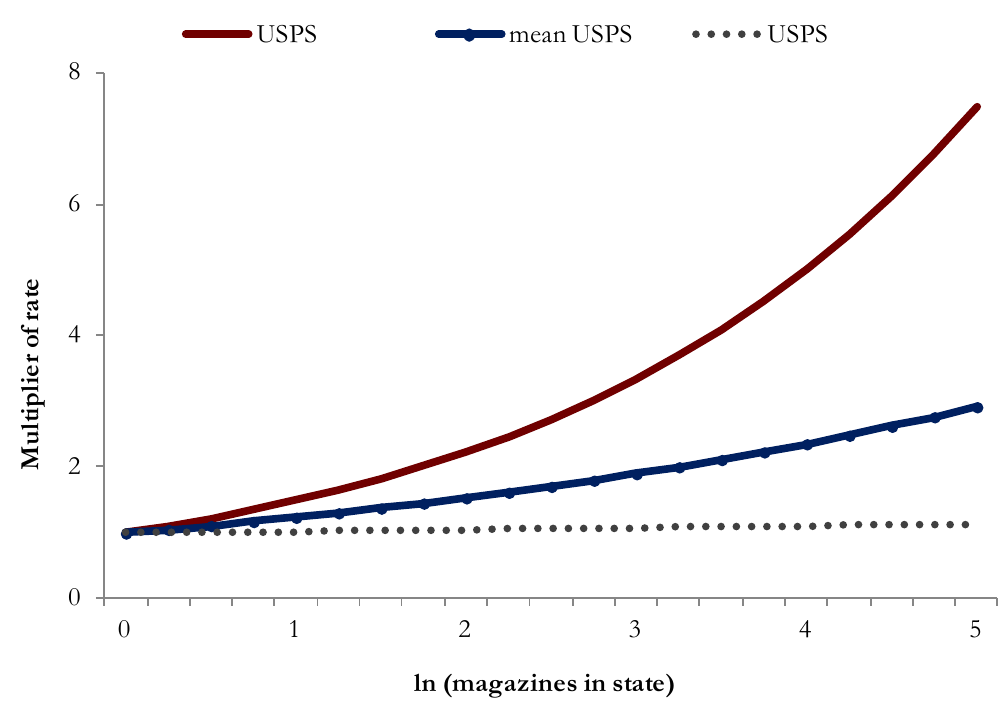
Figure 1a: The effect of in-state magazines on founding